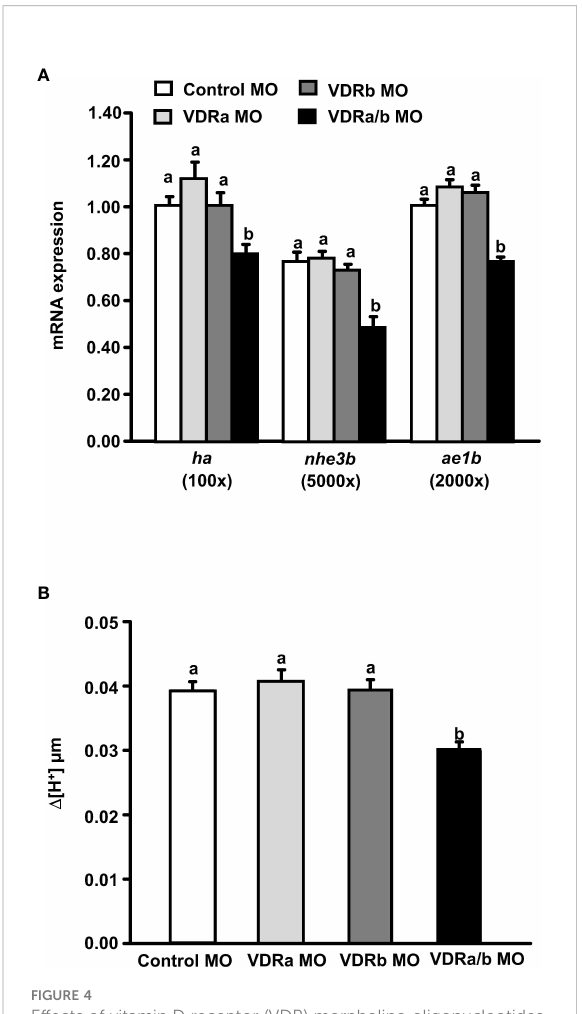
FIGURE 4 Effects of vitamin D receptor (VDR) morpholino oligonucleotides (MOs) on (A) the mRNA expression of transporters and (B) proton secretion in the skin surface of 3 dpf zebra fi sh larvae. The mRNA expressions were analyzed by qPCR, and the values were normalized to b -actin. SIET was used to measure the H + activity on the skin. Different letters indicate a signi fi cant difference (p < 0.05), as determined using one-way ANOVA followed by Tukey ’ s multiple-comparison test. Values were expressed as the mean ± SEM (n = 6 – 12).